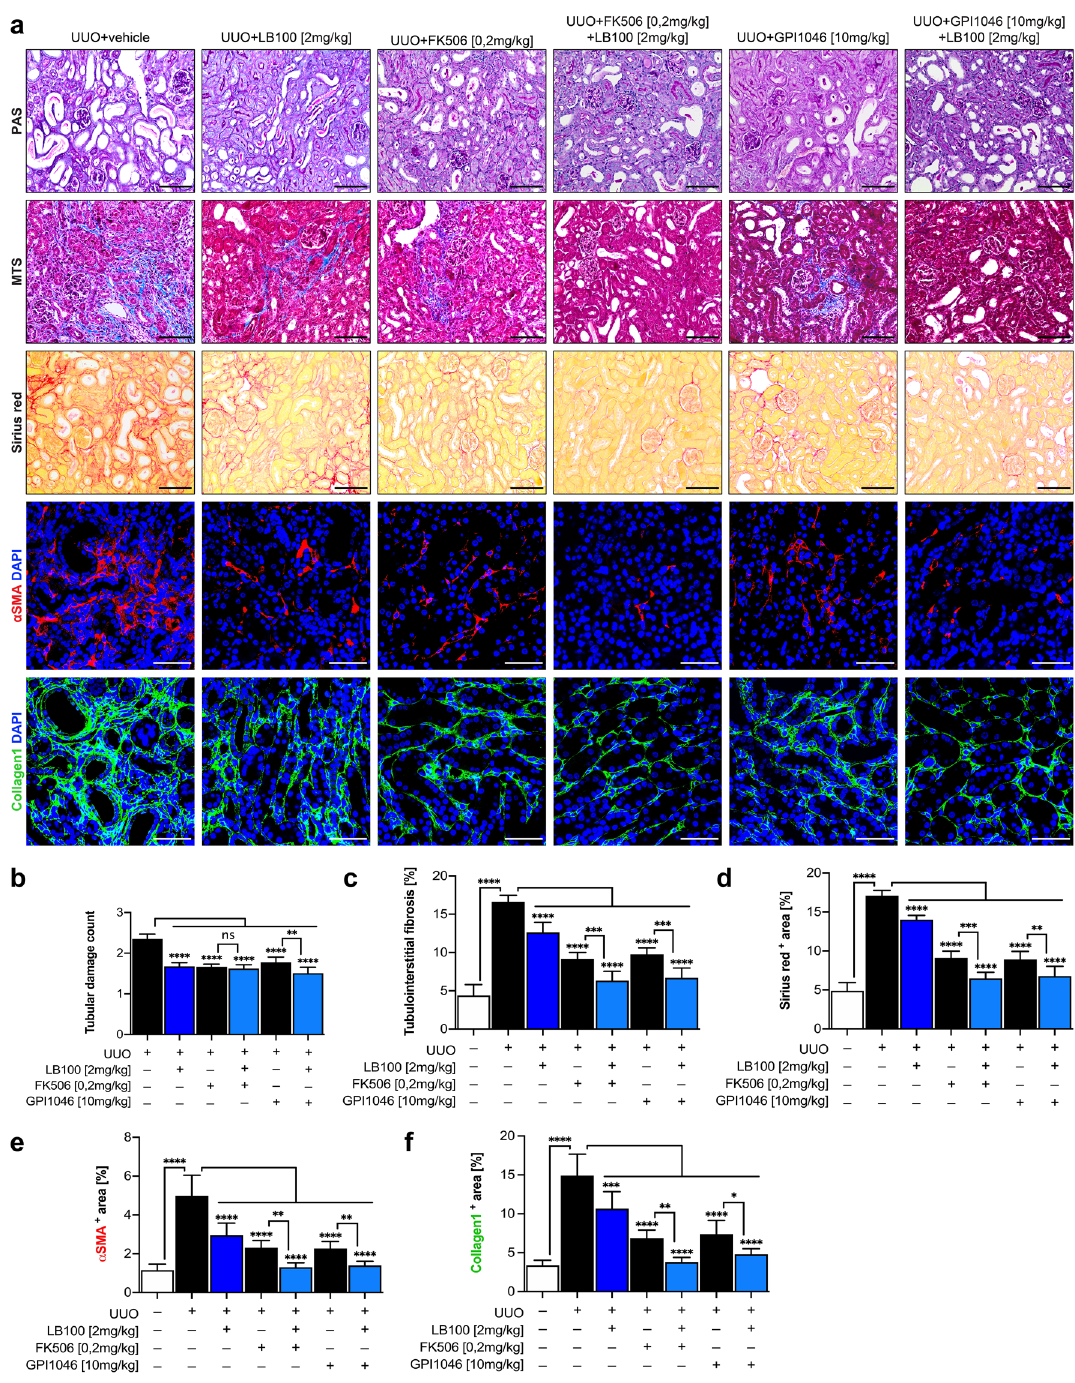
Figure 4. Enhanced formation of ARNT homodimerization effectively protects mice from experimental chronic kidney injury. ( a ) Representative light microscopy images of Periodic acid Schiff (PAS, top), Masson’s trichrome stain (MTS, middle) and Sirius red (bottom) stained sections of the renal cortex from indicated groups. n = 6 in each group. Scale bars: 25 µm. Immunofluorescent labeling for αSMA (red) and Collagen1 (green) staining, indicating the fibrotic area in the renal cortex in each group. Scale bars: 15 µm. ( b ) Quantitative analysis of tubular damage by PAS staining from the indicated group. ( c – f ) Graphs of the interstitial fibrotic area by MTS, Sirius red, αSMA and Collagen1 staining in the renal cortex from each group. *p < 0.05; **p < 0.01; ***p < 0.001; ****p < 0.0001, 1-way ANOVA. Data are shown as mean ±